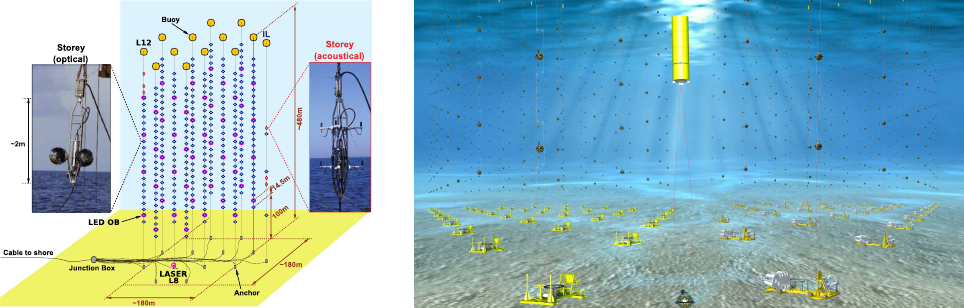
Figure 1. ( Left ) ANTARES schematics; ( Right ) Artist’s impression of KM3NeT (credit: ANTARES and KM3NeT